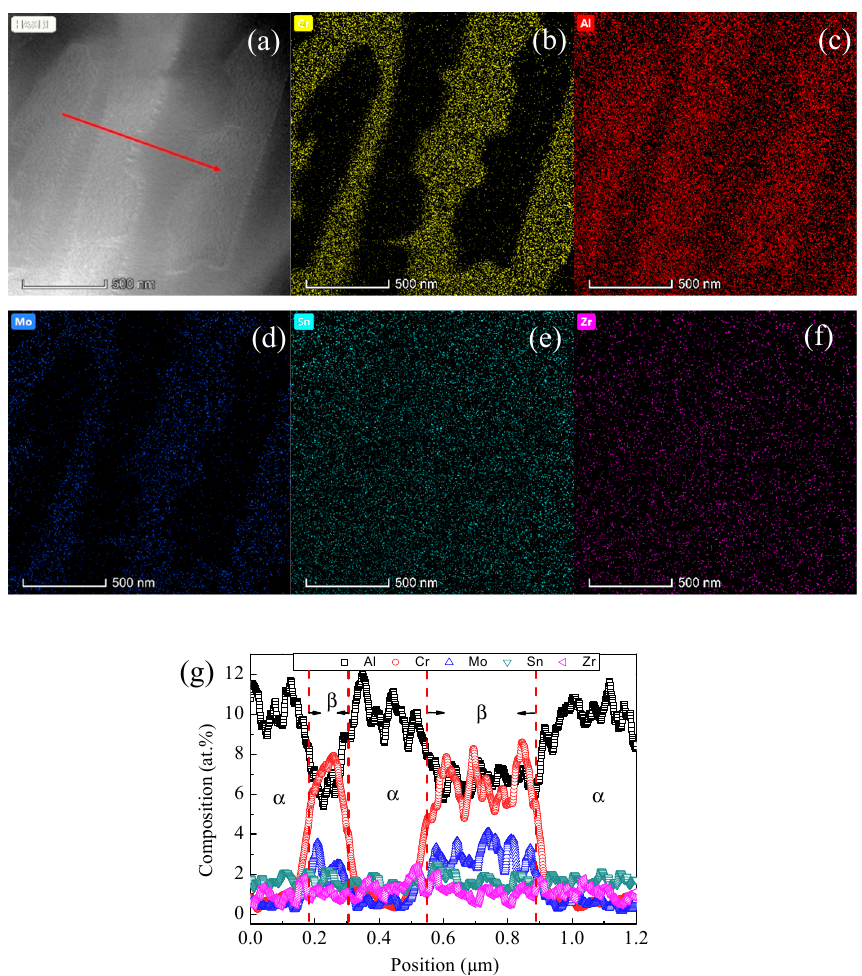
Figure 7. Microstructure and local composition mapping in the sample heated to 1003 K: ( a ) HAADF, ( b ) Al, ( c ) Cr, ( d ) Mo, ( e ) Sn, ( f ) Zr, and ( g ) composition profiles along the red line in ( a ).